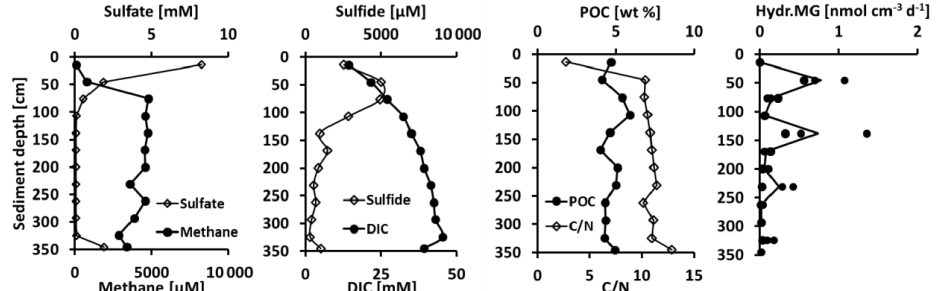
Figure 4. Parameters measured in the sediment gravity core taken in the Eckernförde Bay in September 2013. Hydrogenotrophic (hydr.) methanogenesis rates are shown in triplicates with mean (solid line).